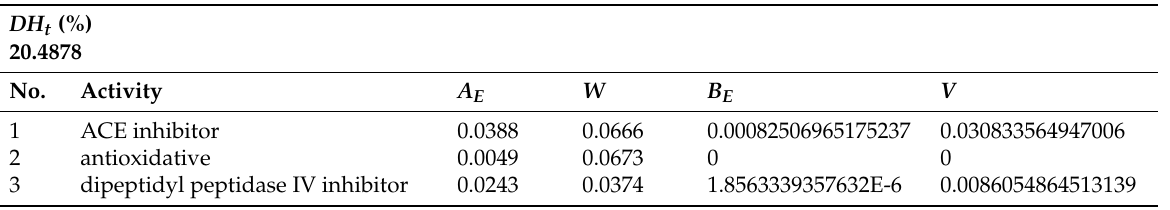
Table A22. A E , DH t , W , B E and V values from RubisCO of Halophila stipulacea . In silico enzymatic cleavage was carried out by cathepsin.